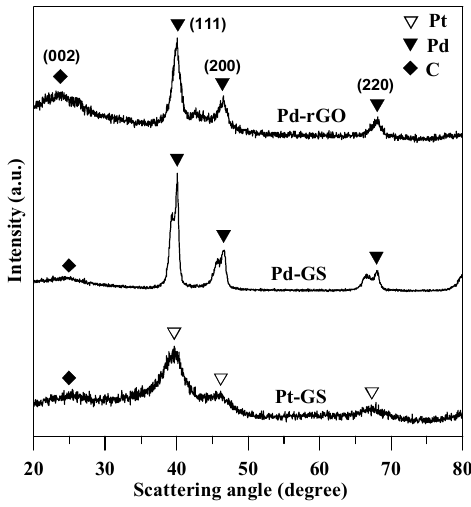
Figure 1. Typical X-ray diffraction (XRD) patterns of different catalyst electrodes.